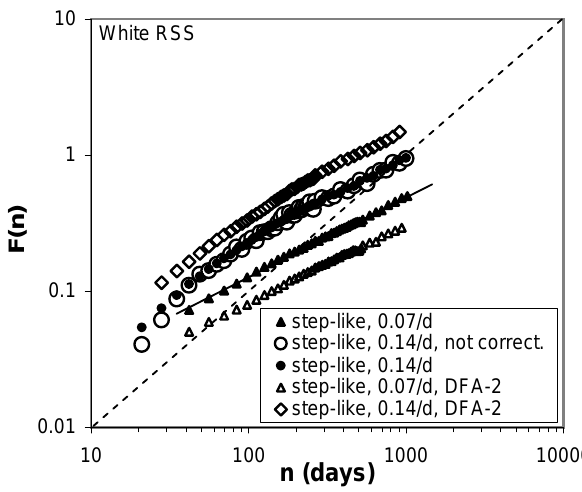
Fig. 4. Fluctuation function F(n) vs. time scale n , for a RSS having Figure 4 . Fluctuation function F ( n ) vs. time scale n , for a RSS having white noise correlation white noise correlation (theoretical α = 0 . 55). A straight line hav- (theoretical α = 0.55). A straight line having slope α = 1 has been plotted for comparison (dotted). ing slope α = 1 has been plotted for comparison (dotted). DFA was DFA was always coupled to PRS and small- n correction techniques, except for calculation of the always coupled to PRS and small- n correction techniques, except data group labeled “not correct.”. Resampling frequencies were both 0.14 day -1 and 0.07 day -1 . The for calculation of the data group labeled “not correct.”. Resam- label “DFA-2” indicates second-order DFA analysis. pling frequencies were both 0.14 day − 1 and 0.07 day − 1 . The label “DFA-2” indicates second-order DFA